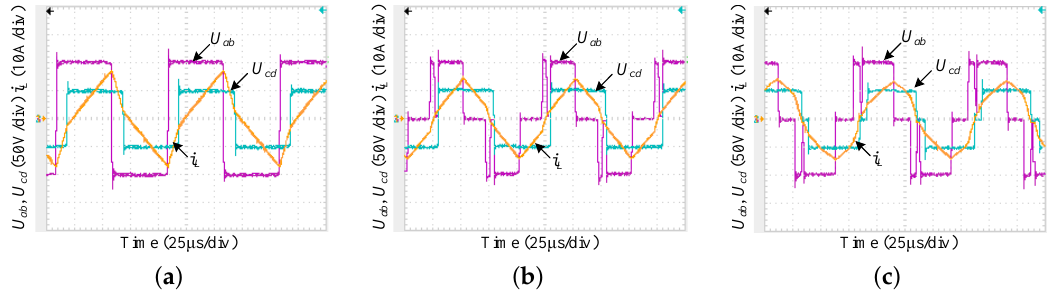
Figure 20. Experimental waveforms of DAB converter with M min = 0.15, k = 2, U 1 = 100 V, P = 400 W: ( a ) SPS scheme; ( b ) UTPS scheme; and ( c ) TPSiDT scheme.